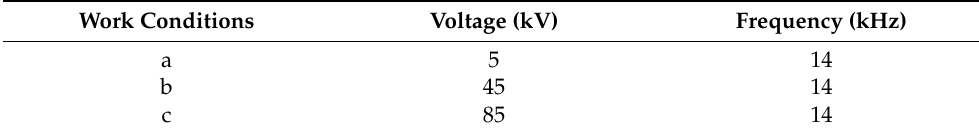
Table 5. Different actuation intensities with 10 mm and 5 mm actuation lengths on inner